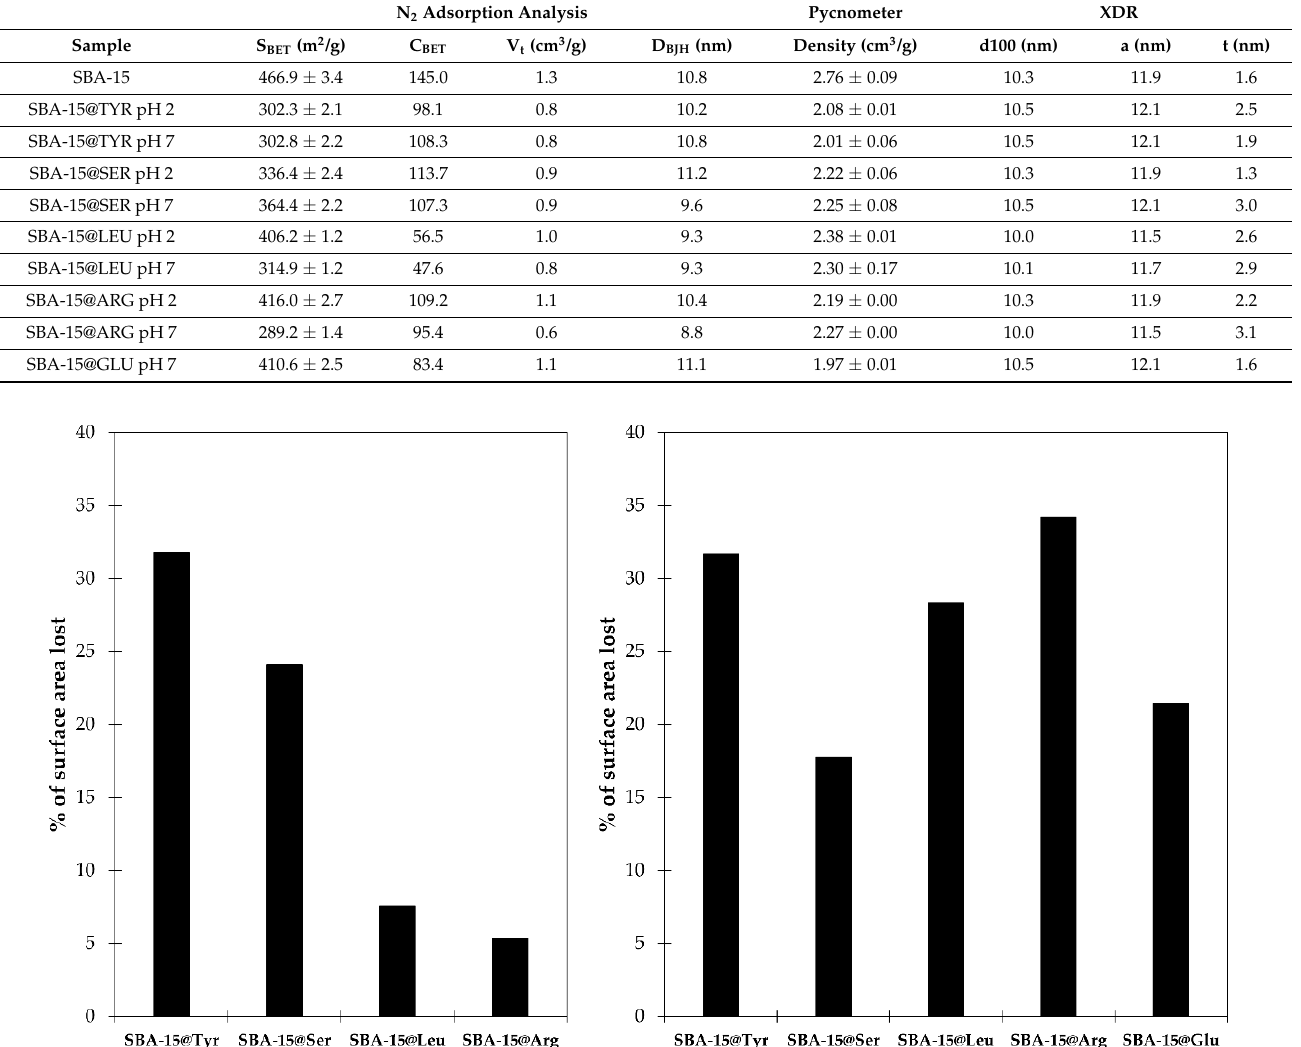
Table 2. Properties of the SBA-15 and SBA-15@AA samples. Surface area (S BET ), C-value (C BET ), pore volume (V t ) and diameter (D BJH ) were obtained by N 2 adsorption analysis; density was measured with a pycnometer and d -Spacing (d100), cell parameter (a) and wall thickness (t) were determined by XDR measurements.